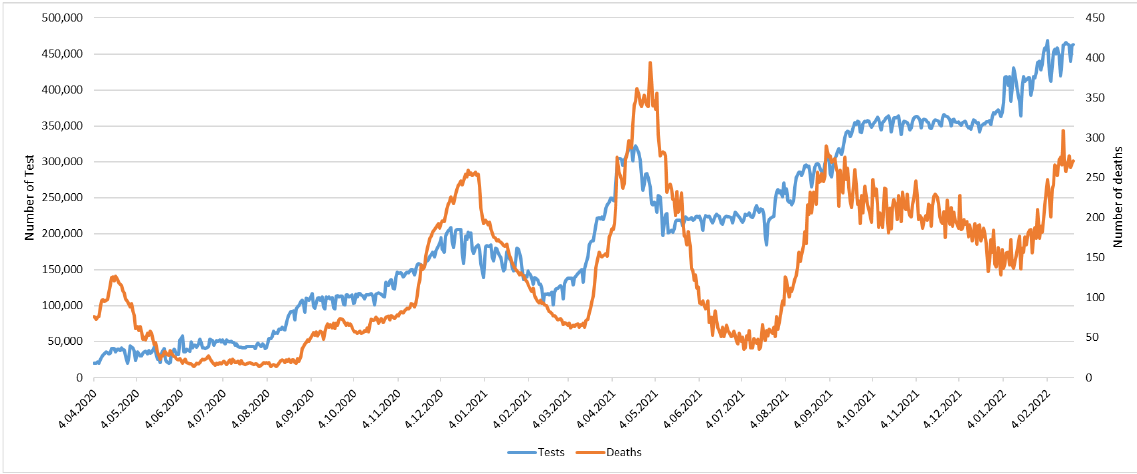
Figure 1. Number of tests and deaths per day.